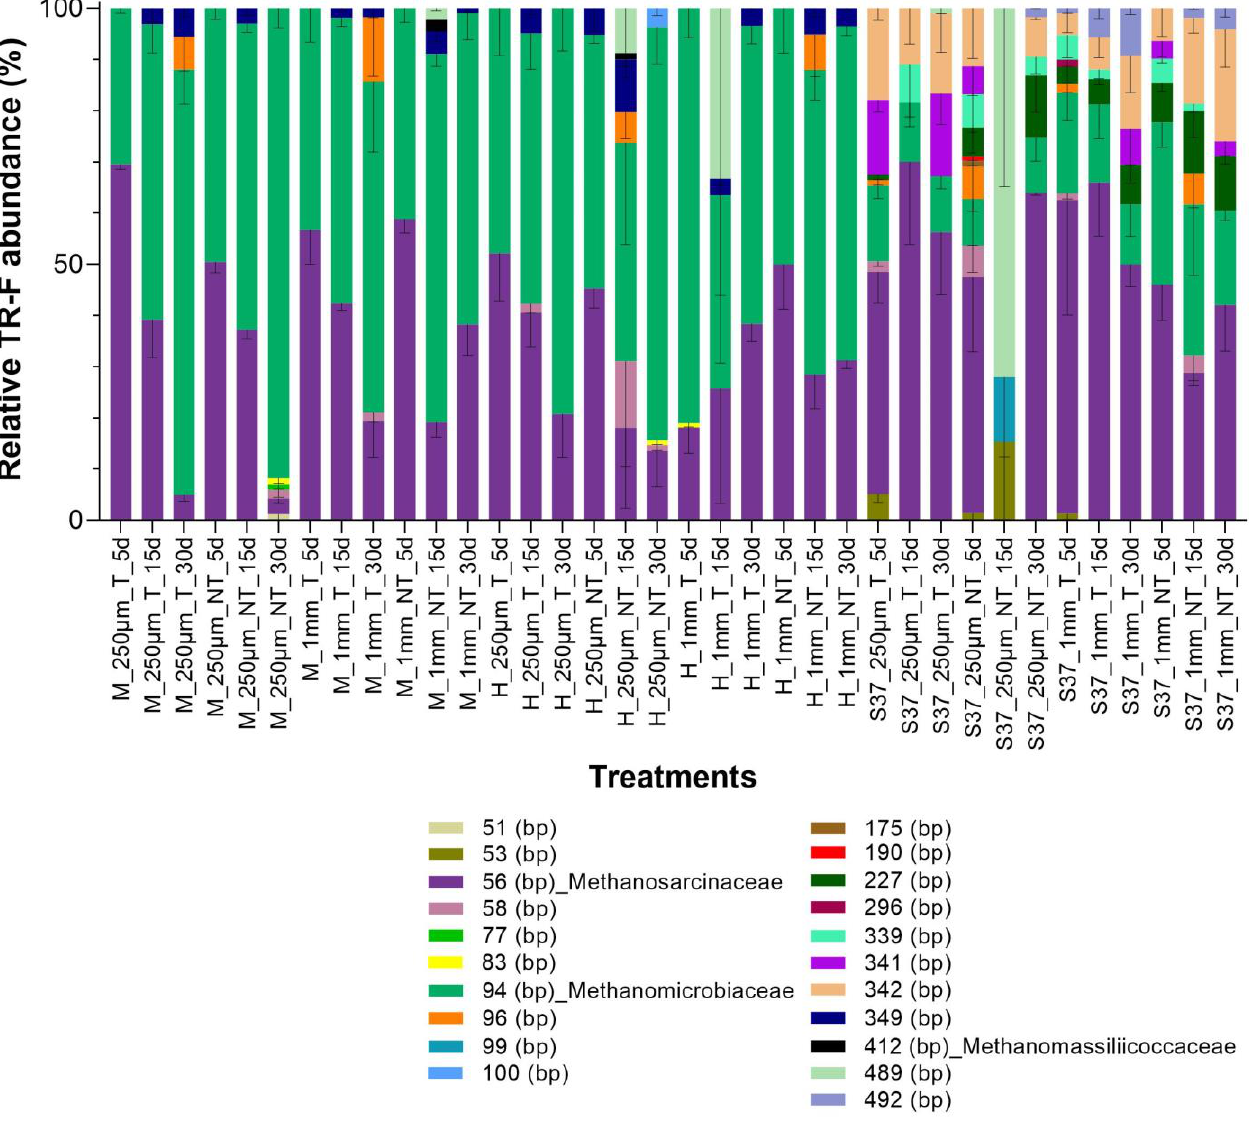
Figure 6. Methanogenic community composition analyzed by T-RF abundance ( n = 3) of the archeal gene mcrA digested with the restriction enzyme BstN I at 5, 15, and 30 days of cultivation in midgut (M), hindgut (H), and Szarvas soda lake (S37) cultures.